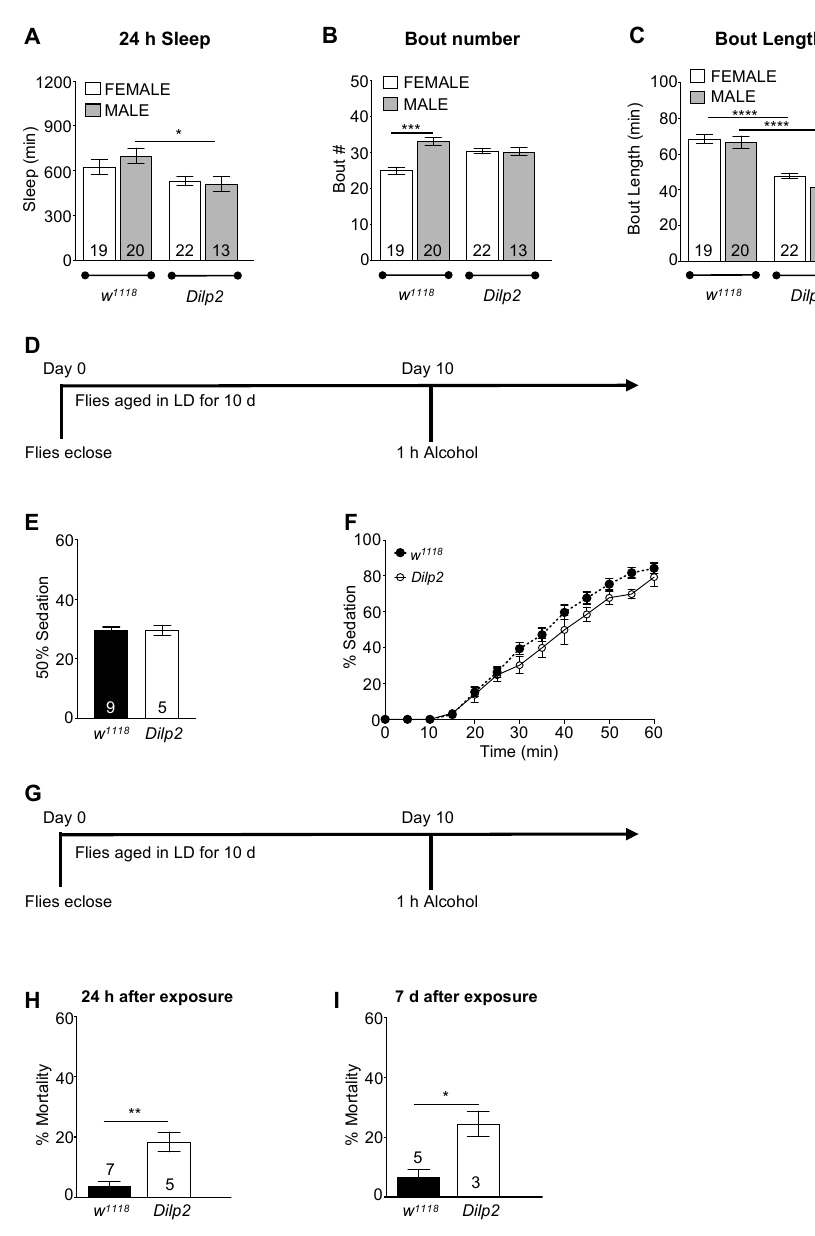
Figure 5. Short-sleeping Dilp2 mutants have significantly increased mortality following a single ex- posure to alcohol with no effect on alcohol-induced sedation. ( A – C ) Sleep profiles of w 1118 and Dilp2 flies. Dilp2 male and female flies had significantly shorter daily sleep times (( A ), ANOVA: F 3,82 = 3.646, p = 0.0160) and shorter bout lengths compared to w 1118 flies (( C ), [ANOVA: F 3,82 = 25.57, p < 0.001], * indicates significant differences as calculated by Bonferroni post hoc analysis; ( B ) [ANOVA: F 3,82 = 13.81, p < 0.001], * indicates significant differences as identified by Bonferroni post hoc analy- sis). ( D ) Dilp2 and w 1118 control flies 10 days of age were exposed to 50% alcohol vapor for 1 h at ZT 9 with sedation assessed every 5 min during alcohol exposure. ( E ) No significant differences in behavioral sensitivity for sedation were observed between Dilp2 and w 1118 controls ( t (12) = 0.035, p = 0.9726). ( F ) The complete time course for w 1118 and Dilp2 flies. ( G – I ) The impact of sleep loss due to mutations in Dilp2 on alcohol-induced mortality was assessed. w 1118 and Dilp2 10 d flies were ex- posed to 50% alcohol vapor for 1 h at ZT 9 with mortality assessed every 24 h for 7 d following exposure to alcohol ( G ). Dilp2 mutant flies showed significantly increased mortality 24 h following exposure to alcohol compared to w 1118 control flies ( t (10) = 4.567, p = 0.0010). ( H ) Mortality in Dilp2 flies continued to rise 7 d following the initial exposure to alcohol ( t (6) = 3.974, p = 0.0073). * indicates